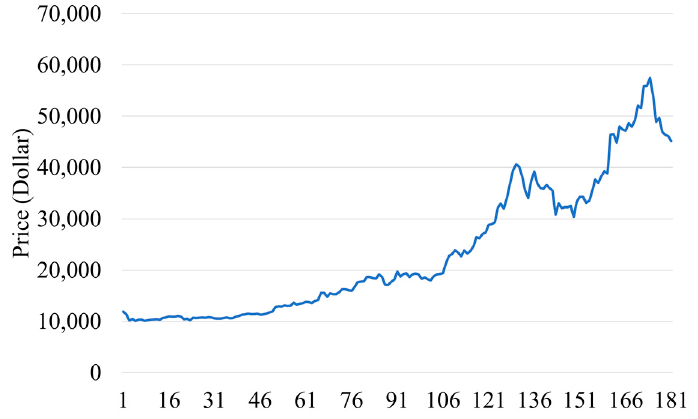
Figure 3. Graph of rising Bitcoin price per day.